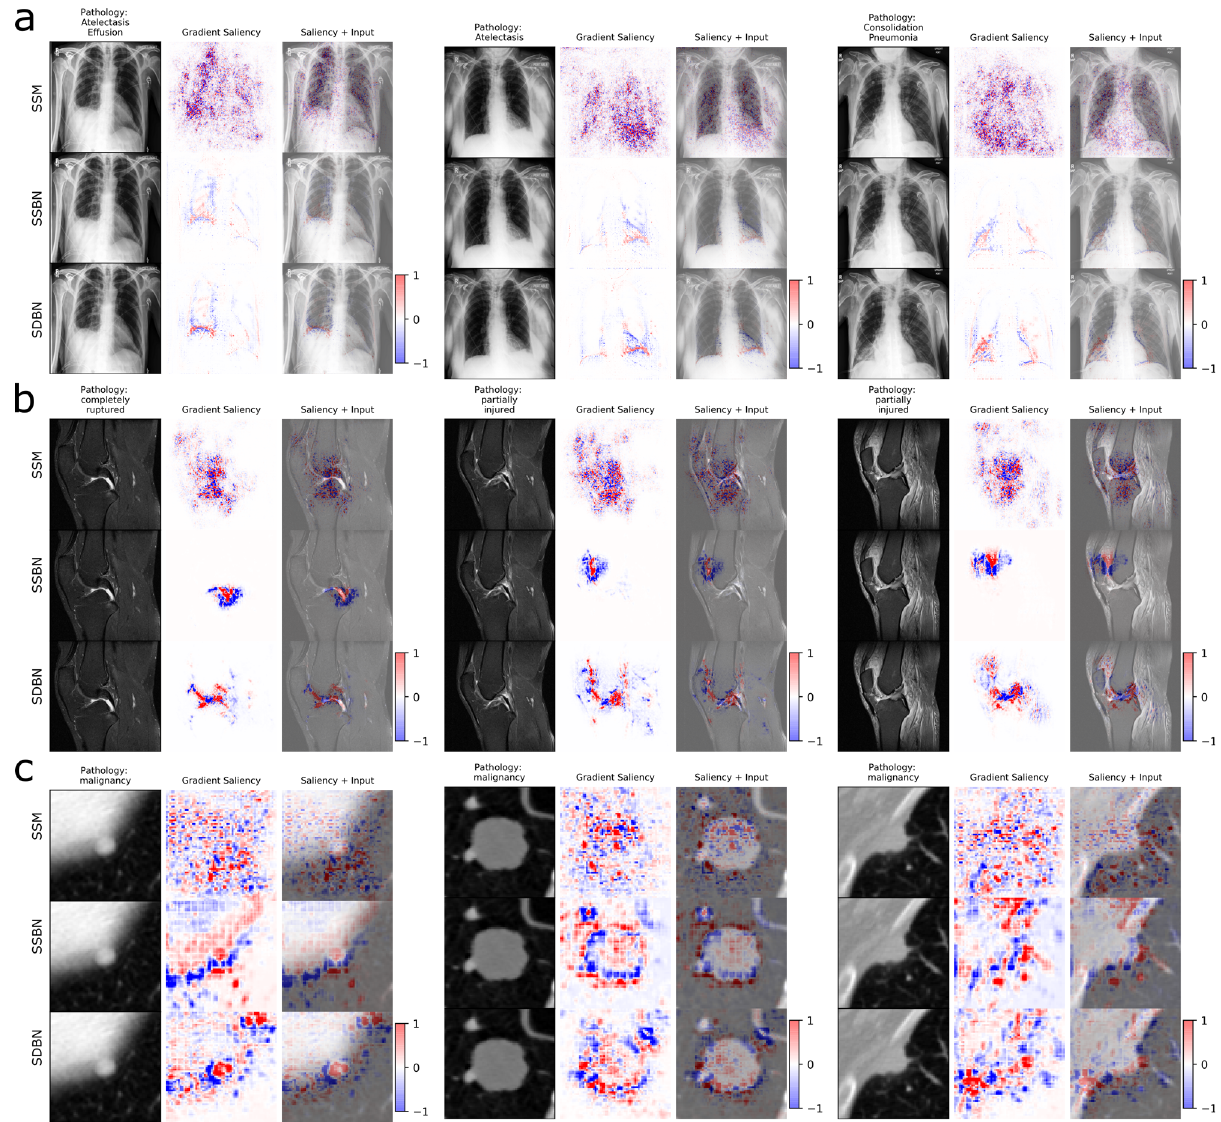
Fig. 6 Saliency maps can help in guiding specialists to the correct diagnosis. Loss gradients were plotted with respect to their input pixels for the X-ray ( a ), MRI ( b ), and CT ( c ) datasets. No extra preprocessing steps were applied to the loss gradients. Here, blue and red colored pixels denote negative and positive gradients individually. For comparison, saliency maps of standard and robust models are presented next to the radiological input. In all three datasets, the SDBN pointed more accurately and more distinctively to the pathology than the SSBN, while the SSM was almost completely uncorrelated and almost noise-like. It can also be observed that the saliency maps created based on neural networks that have been trained on a very large dataset of hundreds of thousands of images ( a ) were more precise in pointing to the pathology, than those trained on datasets containing fewer examples ( b and c